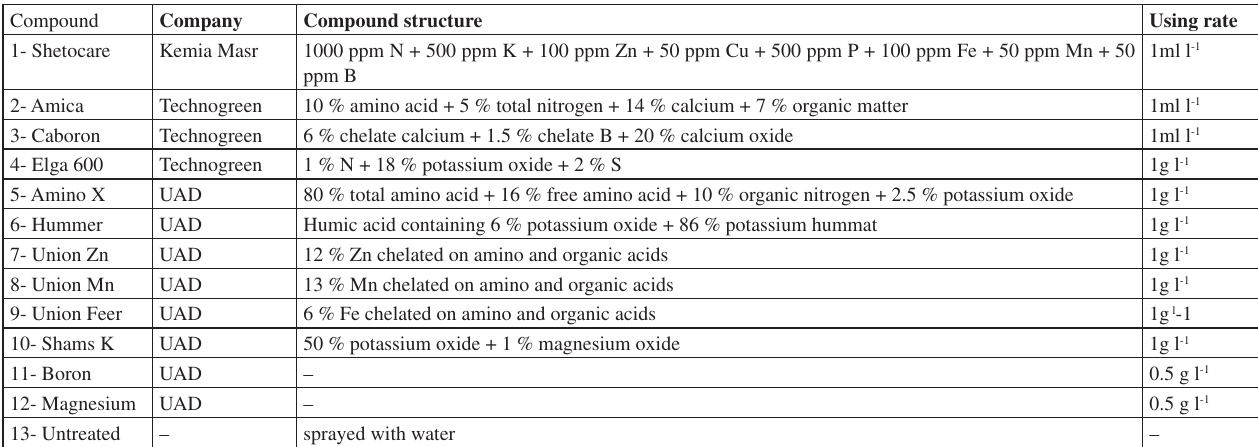
Table 1: Commercial compounds, their structures and using rate of them Compound Company Compound structure Using